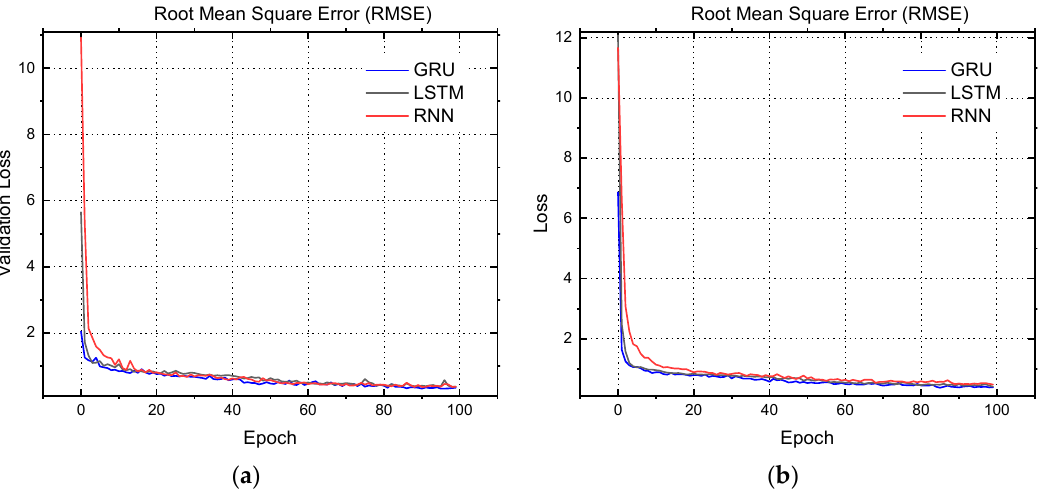
Figure 10. ( a ) RMSE validation loss through GRU, LSTM and RNN; ( b ) actual predicted RMSE Loss through GRU, LSTM and RNN.